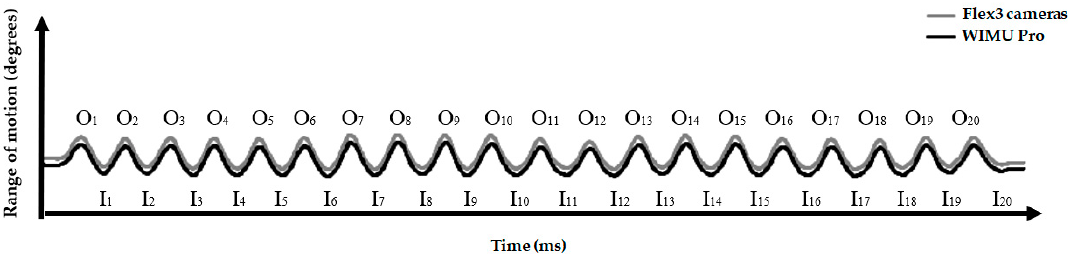
Figure 1. Description of the range of motion from twenty in–out cycles (IOCs) that were performed by one participant recorded by both systems (Flex 3 cameras and WIMU Pro) and separated by in–out phases. (I: in-phase; O: out-phase) .